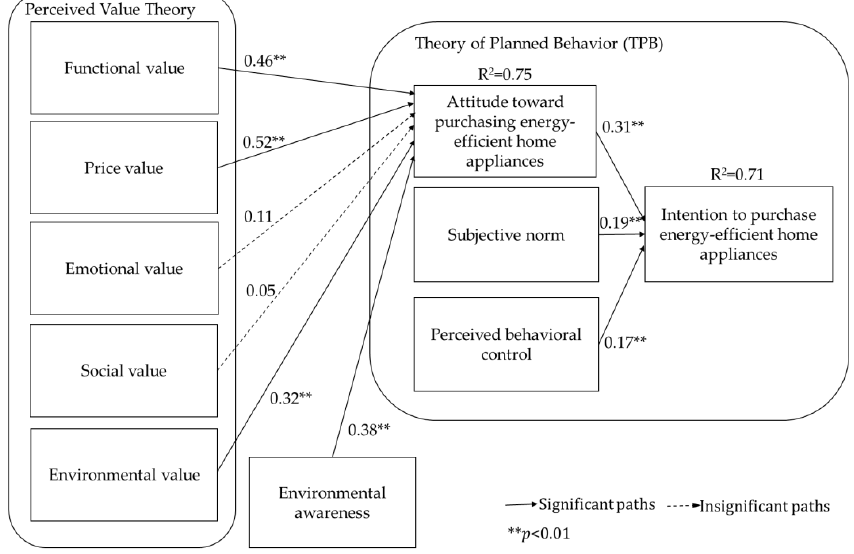
Figure 2. Path analysis